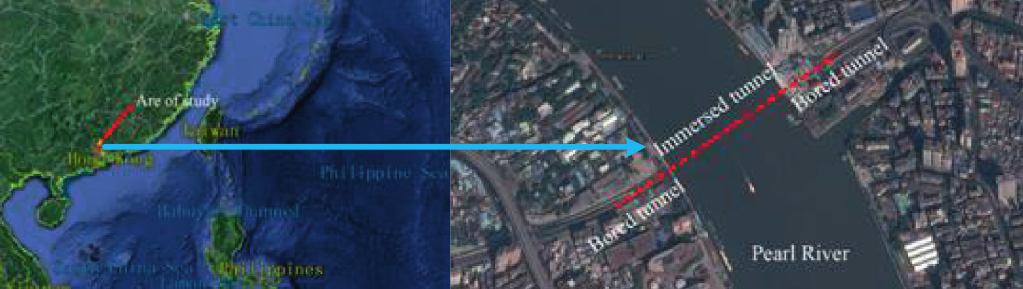
Figure 1: Location of Zhoutouzui immersed tunnel.